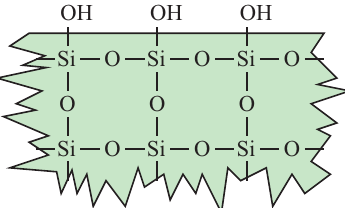
Figure 4. A schematic illustration of the silica structure with surface hydroxyl units. The structure is simplified and presented in a 2D